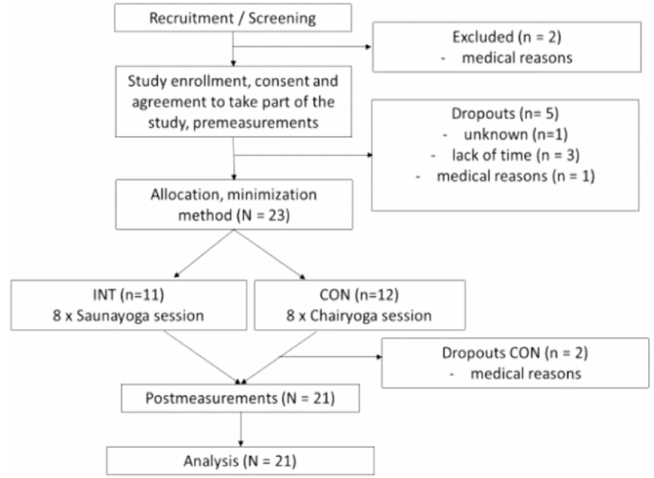
Figure 1. Participant flow throughout the study.